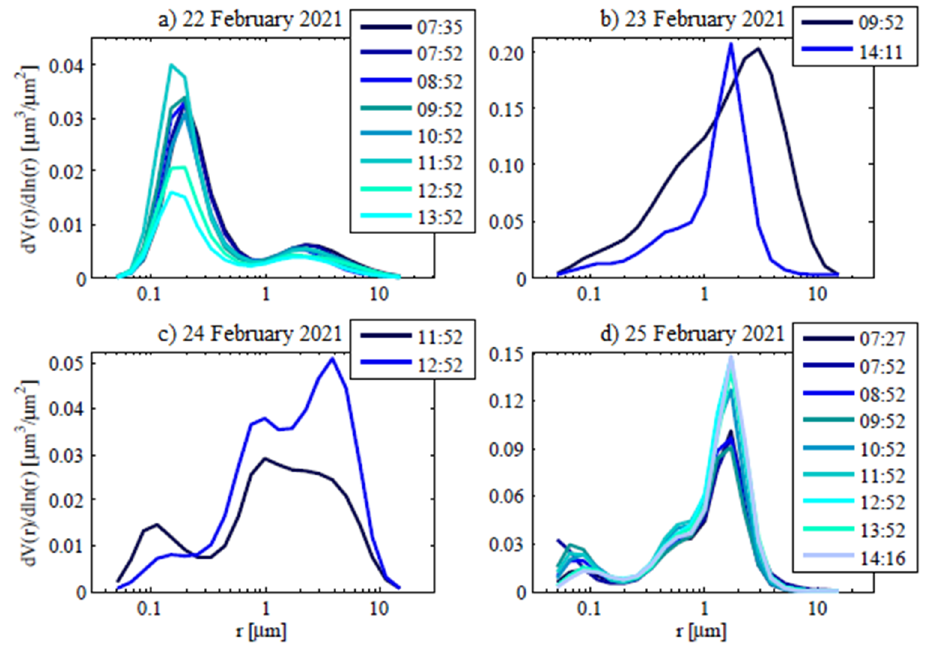
Figure 5. Aerosol size distribution obtained from the almucantar scans via Version 3 Inversion Al- gorithm on ( a ) 22 February 2021, ( b ) 23 February 2021, ( c ) 24 February 2021 and ( d ) 25 February 2021